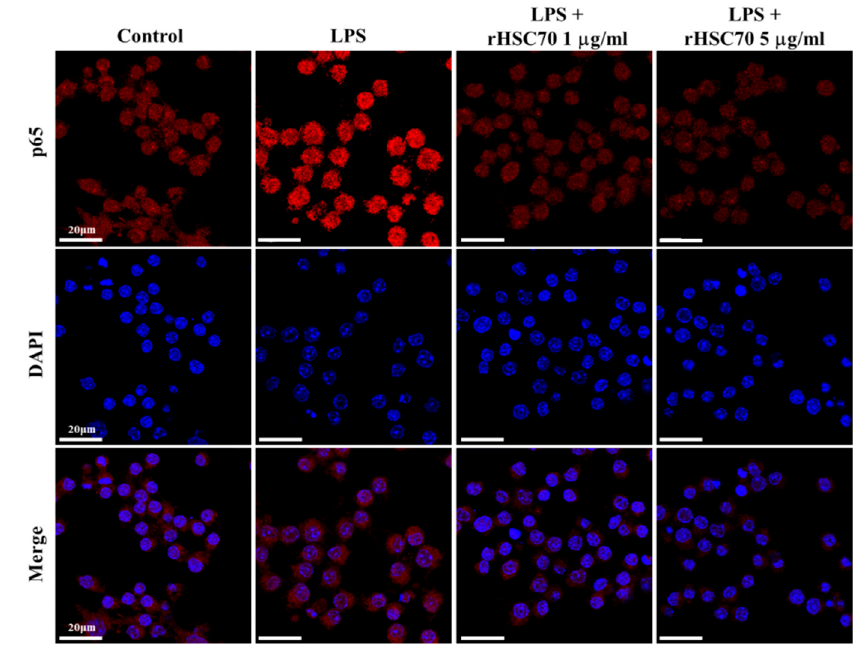
Figure 3. Effects of rHSC70 on LPS-induced translocation of NF-kB. Cells were pretreated with rHSC70 (1 and 5 µg/mL) for 5 min before LPS treatment and 30 min after LPS treatment, the cells followed by immunocytochemistry staining. For the counterstaining, rhodamine-labeled mouse antibody was used. The rHSC70 inhibited LPS-induced translocation of p65 as shown by the location of anti-p65 stain with the nucleus stained with DAPI. Scale bar: 20 µm.